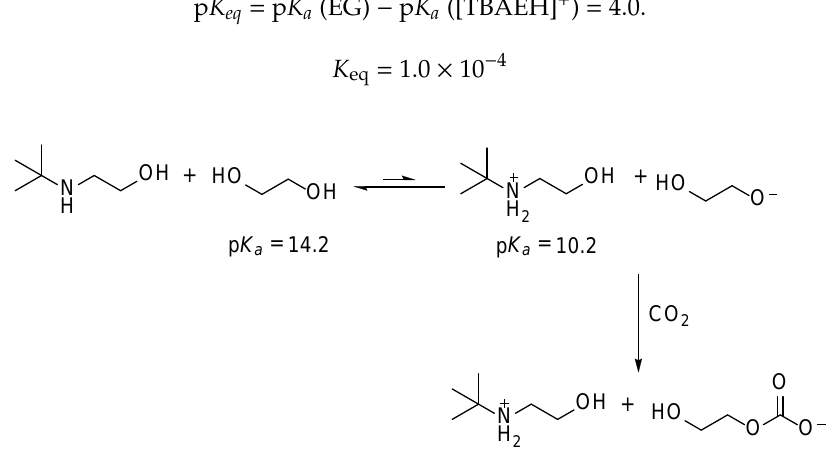
Scheme 2. The possible reaction pathway for the reaction between CO 2 and